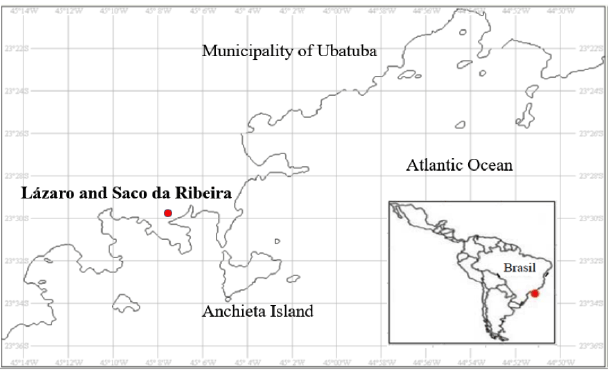
Fig. 1 . Lázaro and Saco da Ribeira Community, Ubatuba, São Paulo,